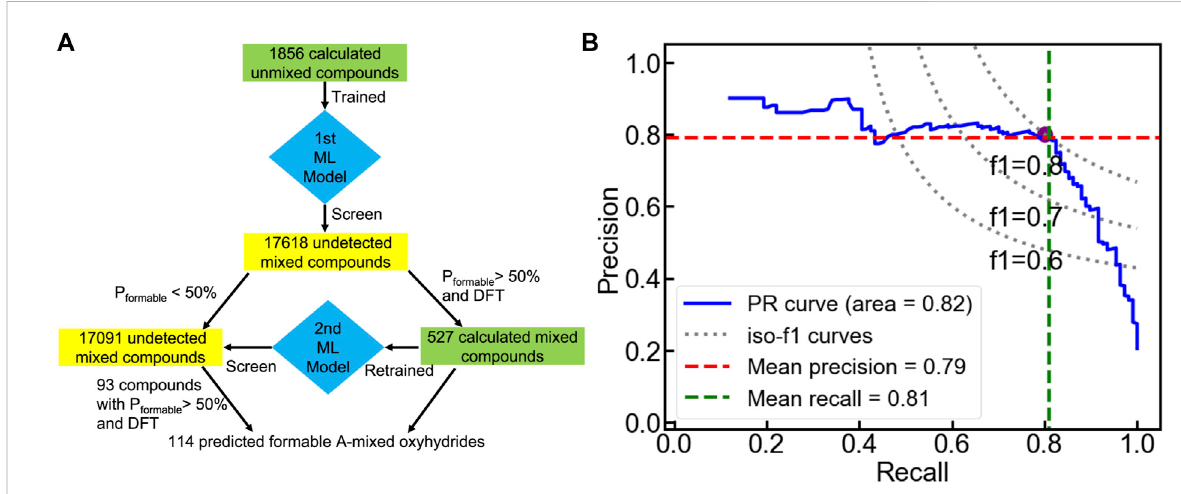
(Figure 8C) and the ROC curve (Figure 8D). Outstanding metrics of the voting model to identify meta/stable compounds indicate its capability of capturing overarching factors impacting oxyhydrides stabilities.